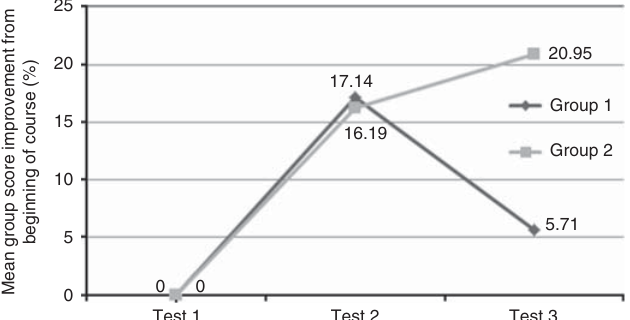
Figure 9. Cumulative percentage polygons of the groups ’ overall